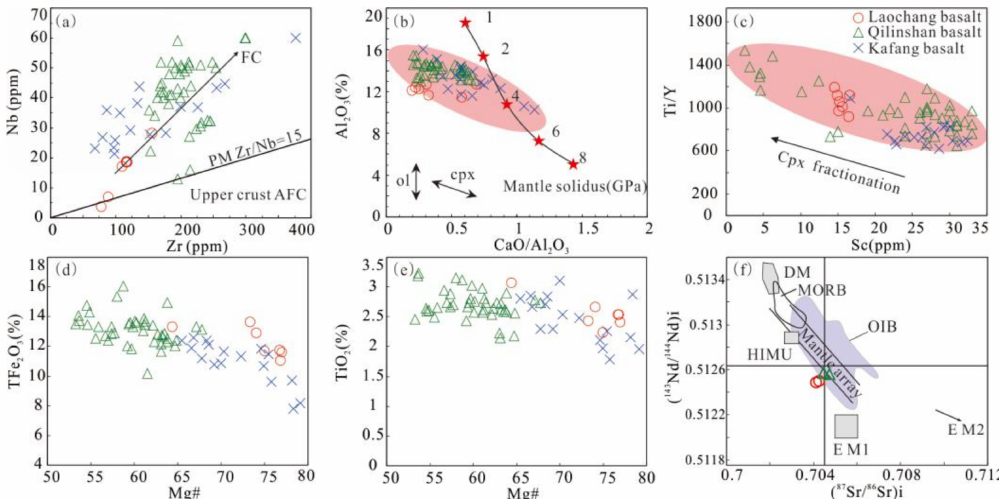
Figure 9. ( a ) Zr vs. Nb diagram (modified from [58]); ( b ) CaO / Al 2 O 3 vs. Al 2 O 3 diagram (modified from [40]), ol: olivine, cpx: clinopyroxene; ( c ) Sc vs. Ti / Y diagram (modified from [7]); ( d ) Mg# vs. TFe 2 O 3 diagram; ( e ) Mg# vs. TiO 2 diagram; ( f ) ( 87 Sr / 86 Sr)i vs. ( 143 Nd / 144 Nd)i (modified from [58]). The data of Kafang from